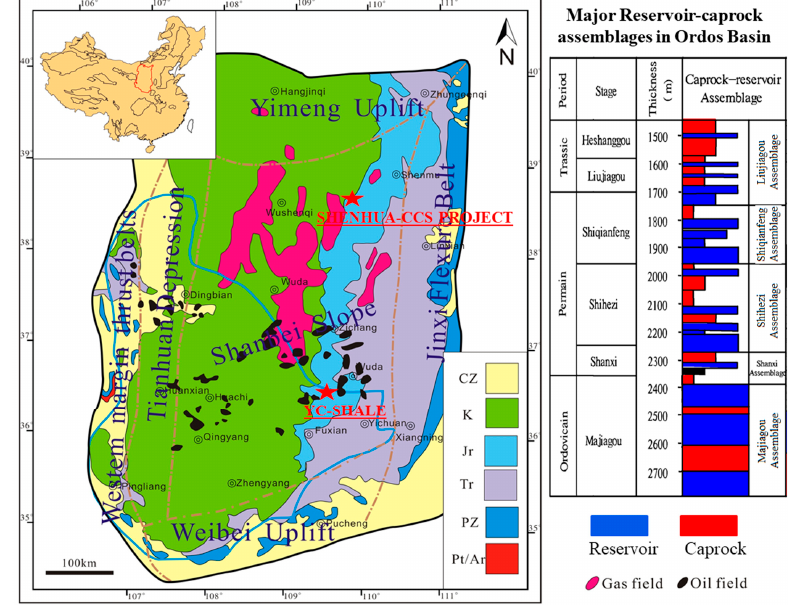
Figure 1. Geological map and oil / gas resources distribution in the Shannbei slope of the Ordos basin, China (Modified from [23,24]).